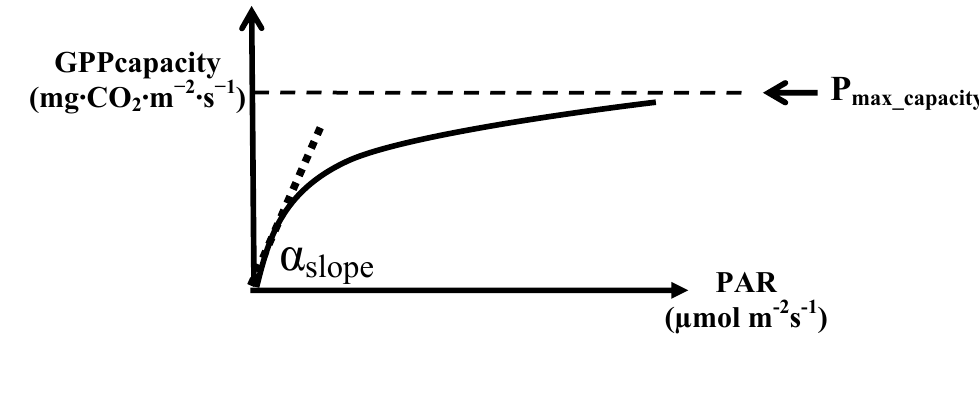
Figure 1. Canopy light-response curve. Low-stress global gross primary production ) (mg·CO ·m − 2 ·s − 1 ) is the low-stress GPP, P (GPP capacity 2 maximum GPP under light saturation, and α capacity representing the initial slope of the light-response